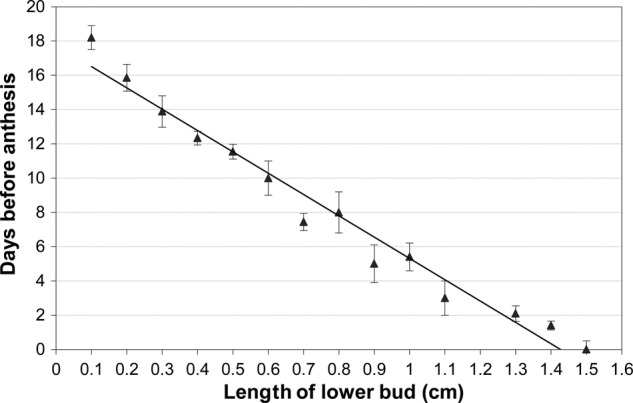
Relationship between days before anthesis and length of flower bud in cultivated strawberry. The regression model fitted (days before anthesis = −12.443x + 17.754, R2 = 0.97, P < 0.001) is depicted. Each data point is the mean ± SE, n = 20.